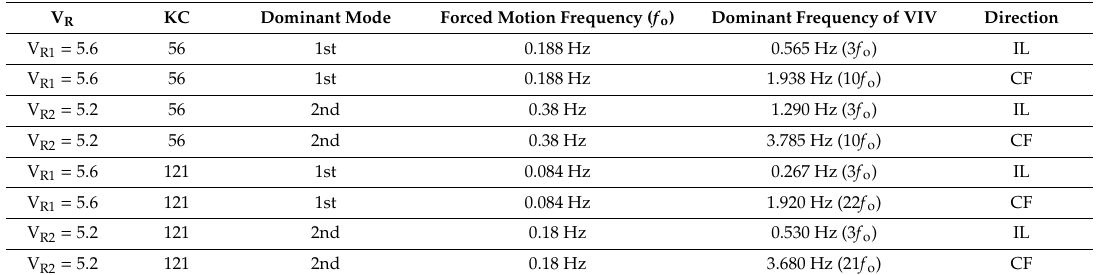
Table 4. Summary of dominant frequency of VIV for di ff erent test